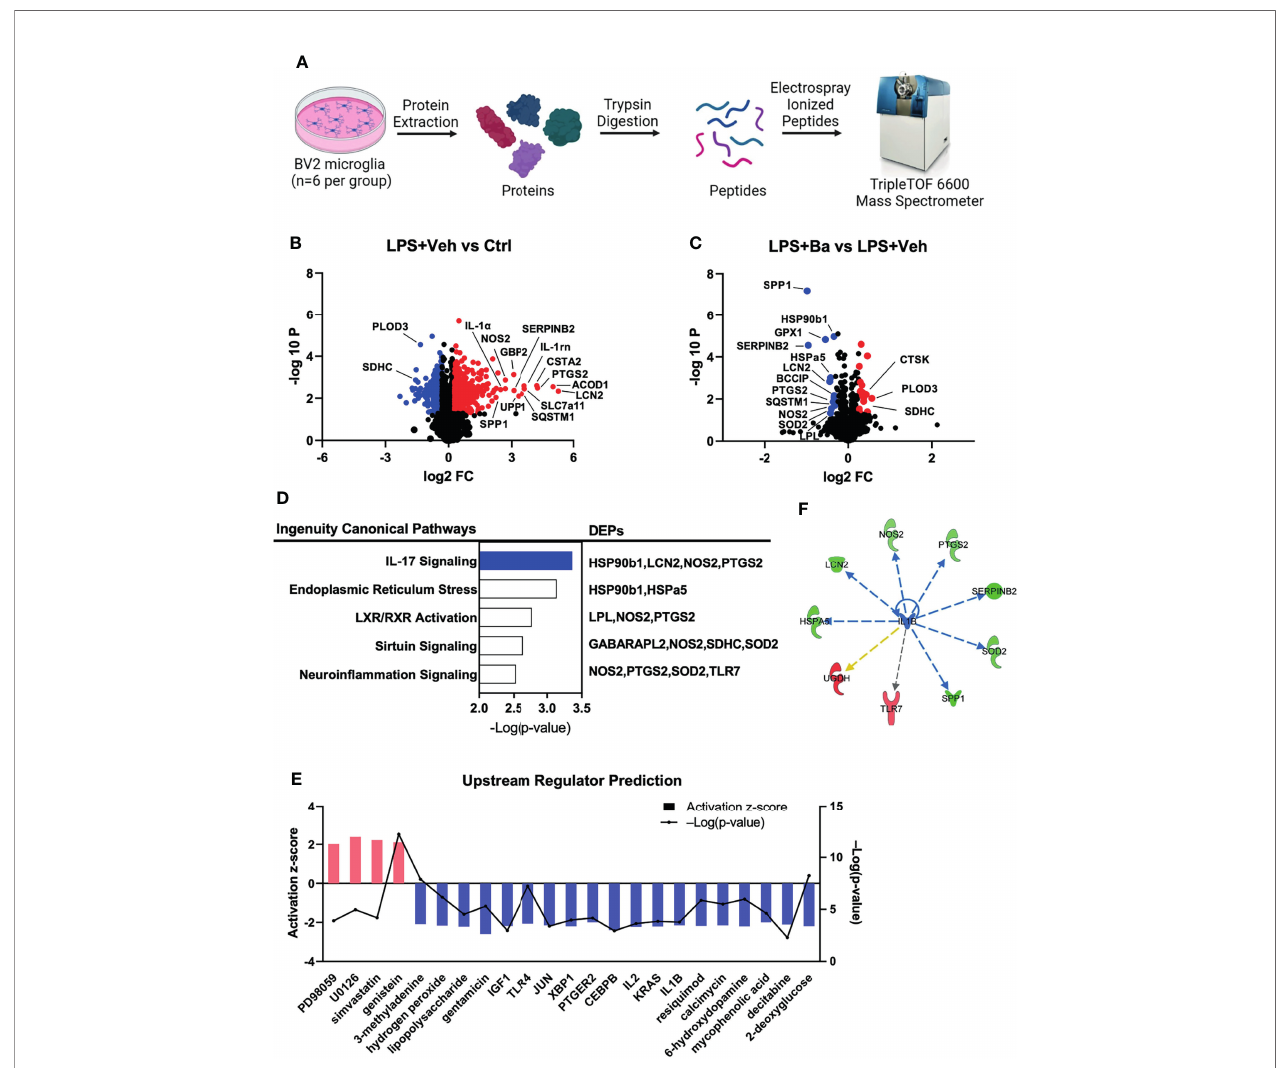
FIGURE 3 | Proteomic analysis further reveals IL-17 signaling and upstream regulator of IL-1 b inhibited by baicalein on LPS-primed microglia. (A) Graphic illustration of the design of proteomics study. The illustration was created with BioRender. Volcano plot showing the differentially expressed proteins (DEPs) in the groups of (B) LPS + Veh vs. Ctrl and (C) LPS + Ba vs. LPS + Veh. Red dots represent the upregulated DEPs ( P -value < 0.05 and FC > 1.2) and blue dots are the downregulated DEPs ( P -value < 0.05 and FC ≥ 1.2). (D) Top 5 canonical pathways (left) enriched by IPA analysis of involved DEPs (right) in BV2 cells (LPS + Ba vs. LPS + Veh). Bar chart was presented with the log-transformed P -value, representing the top disease-related biological pathways and involved proteins in each pathway. Blue and white bars represented z -score = − 2 and 0, respectively. (E) Upstream regulator predication by IPA; bar represented the activation z -score, and the line chart represented – Log( P -value). (F) Representative network showed the interaction between the upstream regulator IL-1 b and its downstream molecules. Red and green colors represented increased and decreased measurement in the samples. Blue, yellow, and gray lines with arrow represented inhibition, fi ndings inconsistent with state of downstream molecule, and effect not predicted, respectively. N = 6 biological